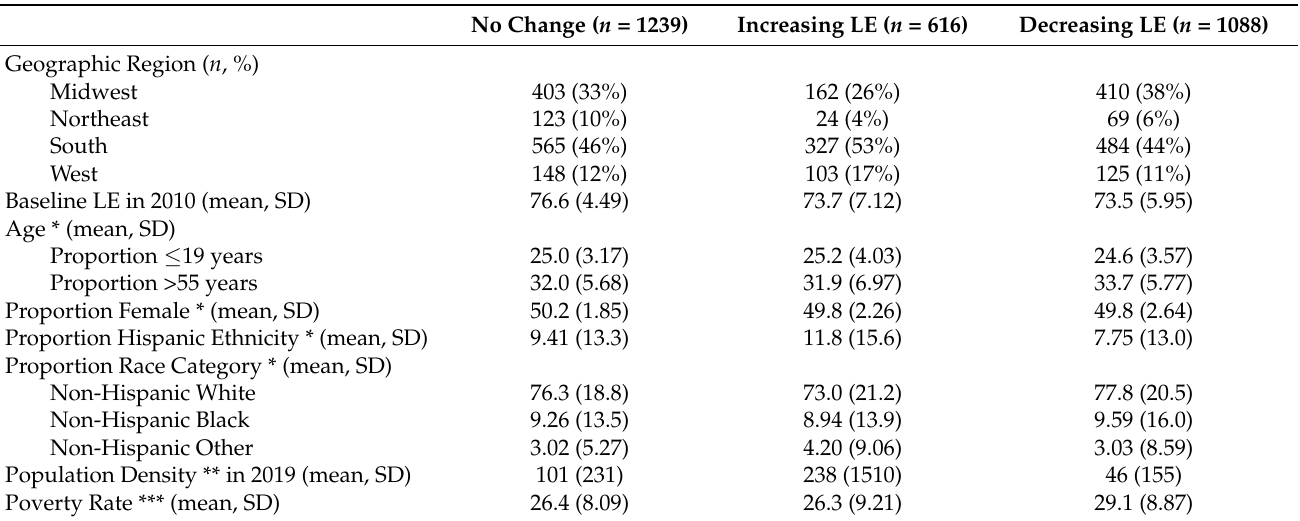
Table 2. Core sociodemographic characteristics of no-change, increasing life expectancy (LE), and decreasing LE counties (N = 2943 counties).